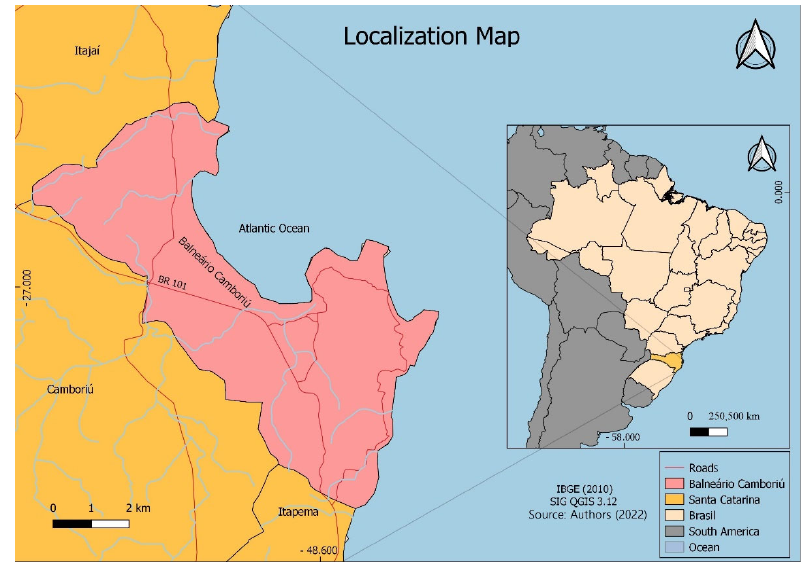
Figure 1. Location map of Balneário Camboriú/SC, Brazil.